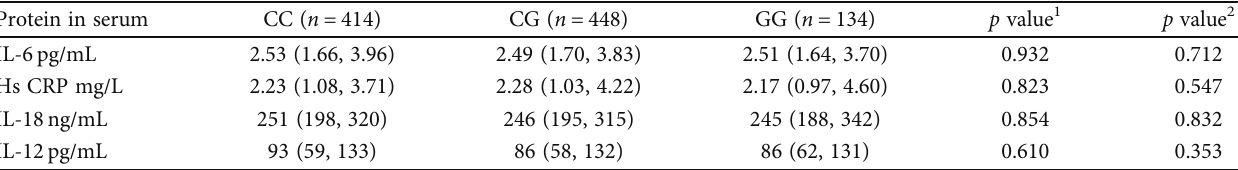
p 1 values represent the di ff erence between genotypes (Kruskal-Wallis test). p 2 values represent the di ff erence between homozygous wild type (CC) and the G-allele (CG and GG combined) (Mann – Whitney test).